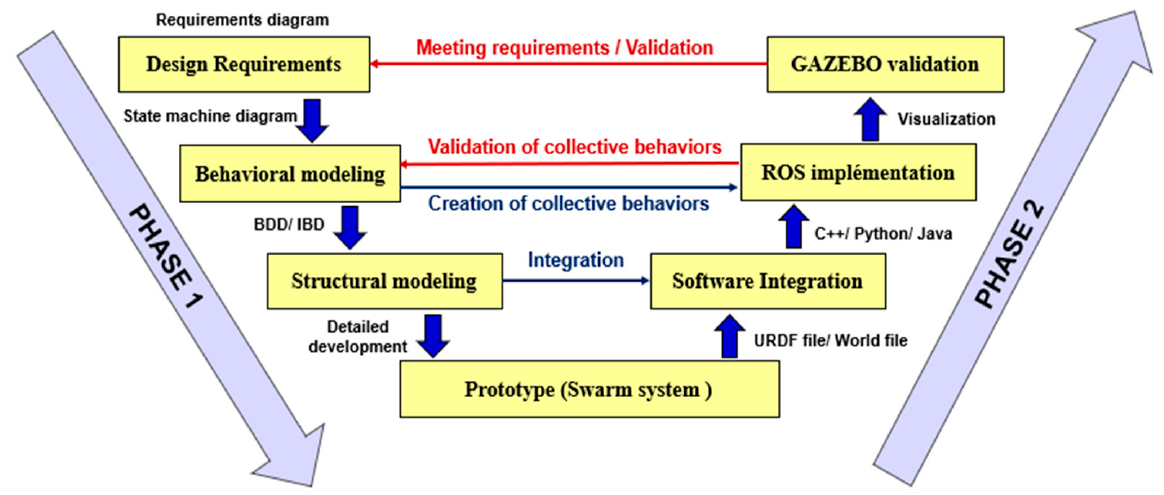
Figure 2. Integrated methodology for designing a swarm system.